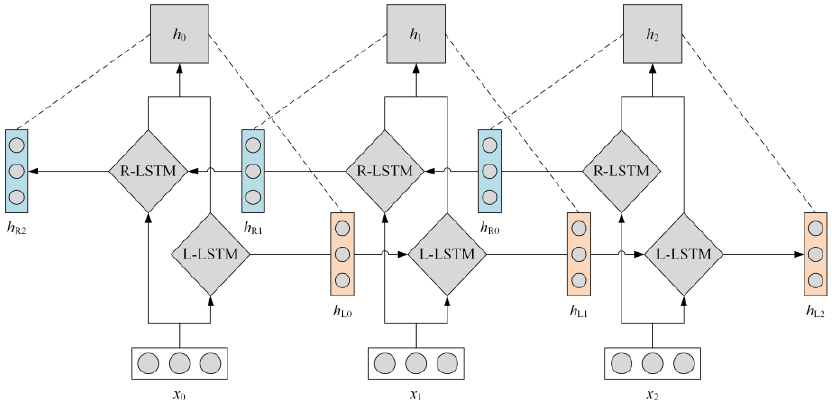
Figure 3. The Bi-LSTM multi-label classification model. 285